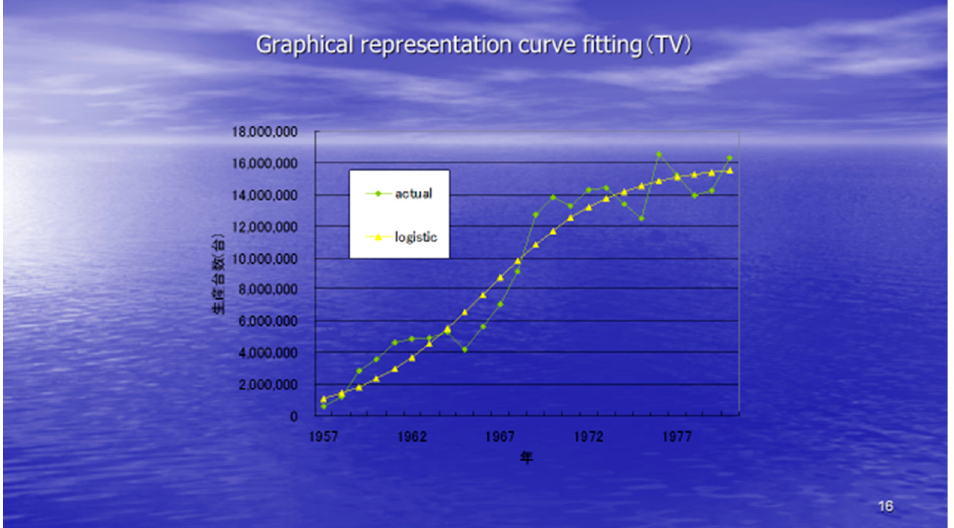
Figure 8. Graphical representation of regression analysis for televisions. Source: Osaki et al. (2001) [26].